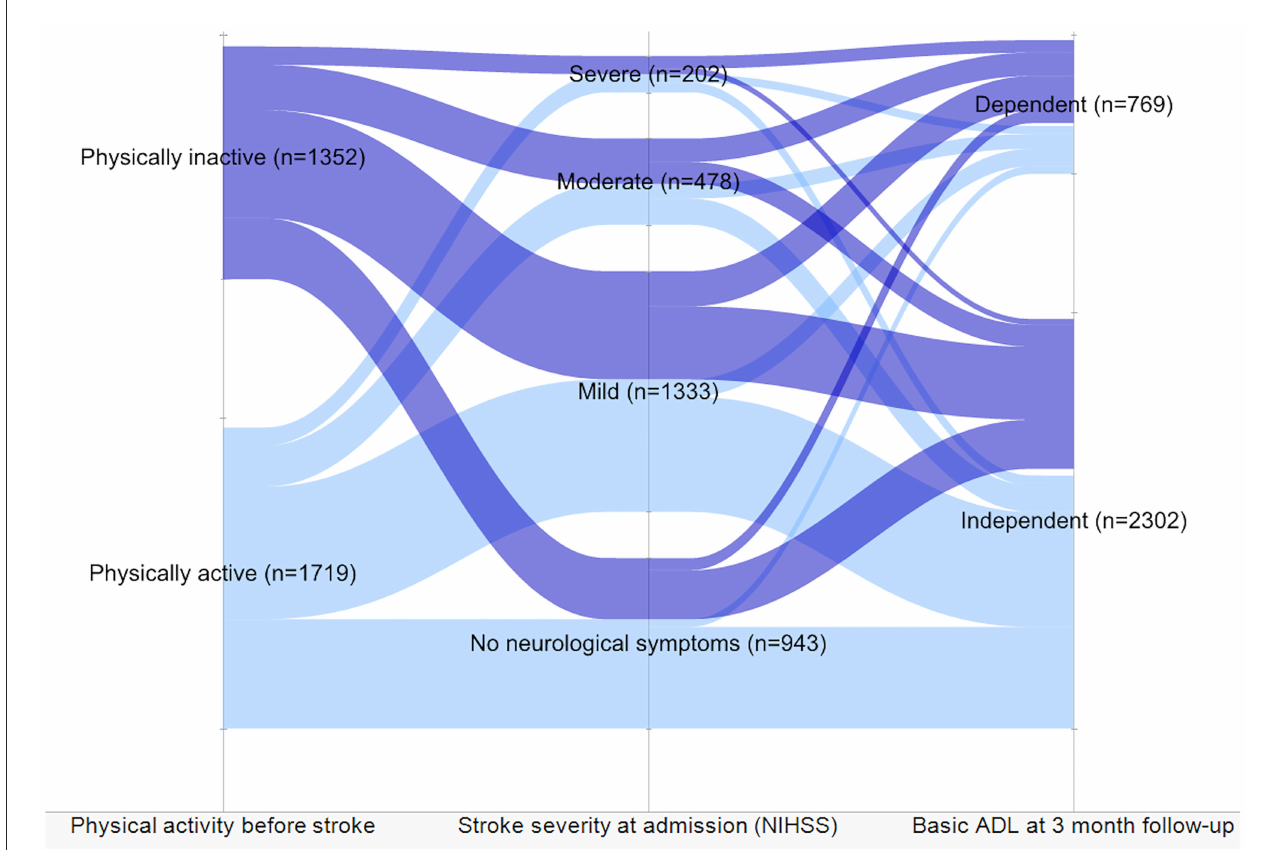
FIGURE4 Level of dependency in activities of daily living (ADL) and stroke severity in patients independent before stroke based on the level of physical activity before stroke. The patients divided by physical activity level before stroke showed stroke severity and dependency 3 months after